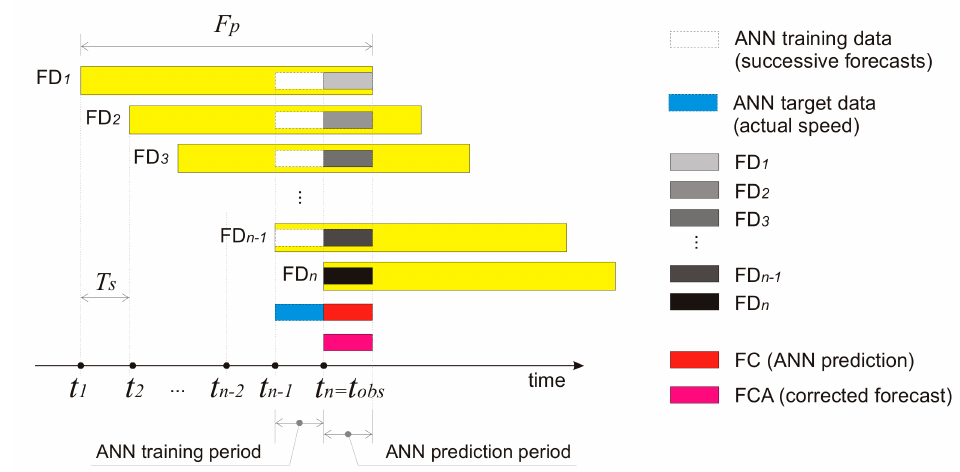
Figure 5. Data sets immediately after receiving a new NWP